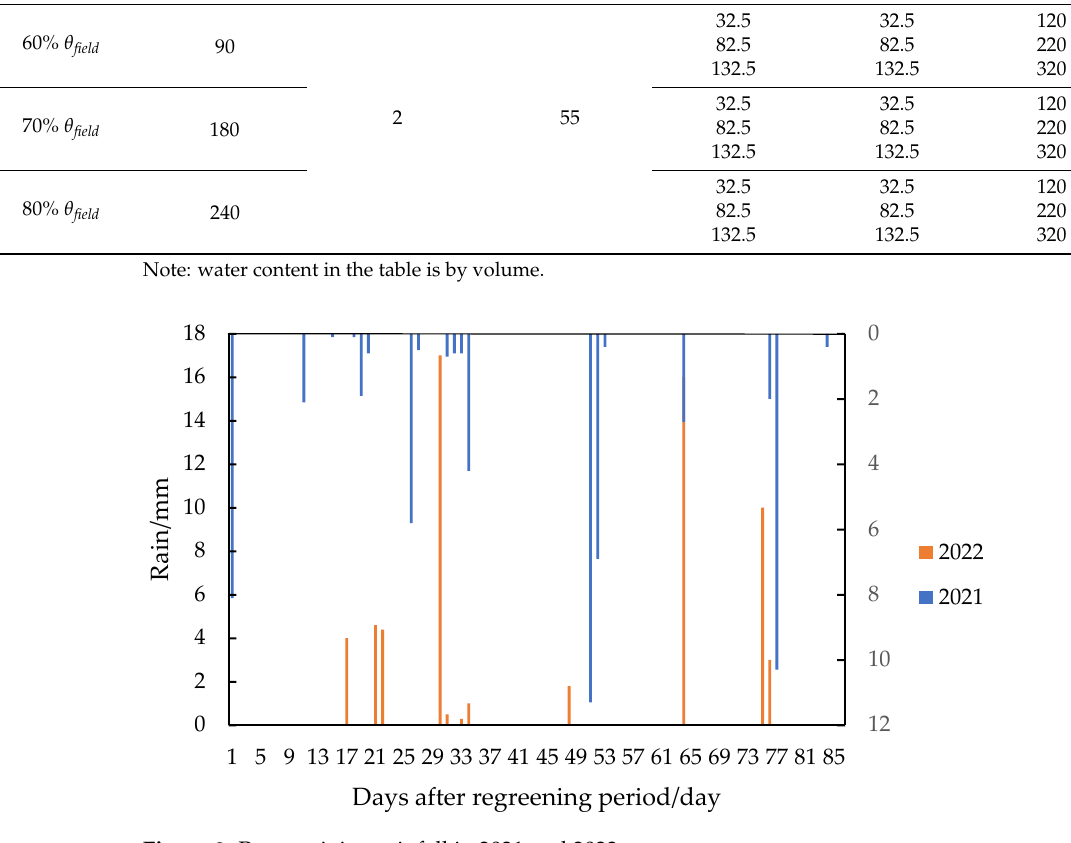
Figure 2. Post-reviving rainfall in 2021 and 2022.